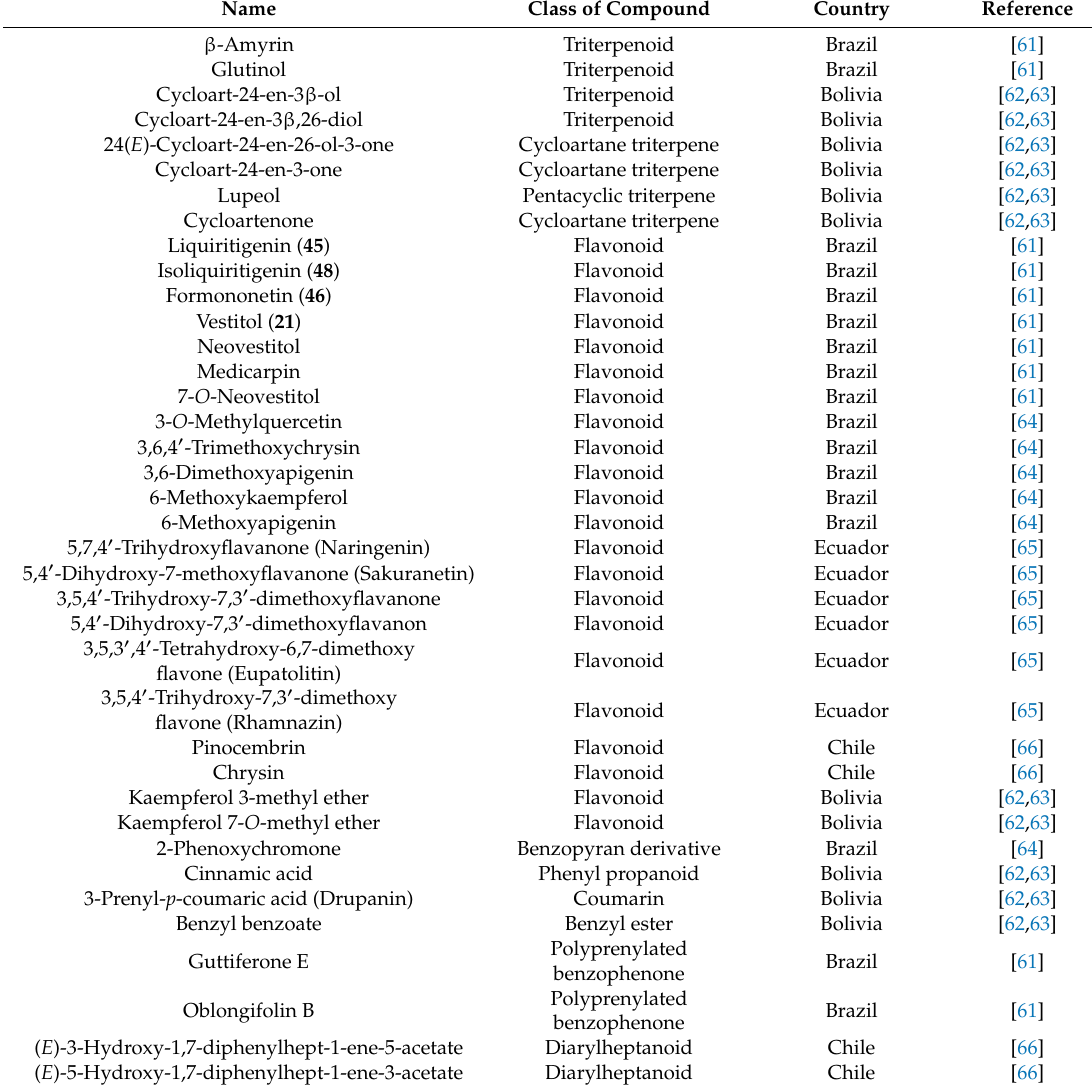
Table 2. Some compounds isolated from South American propolis between 2015 and 2020.